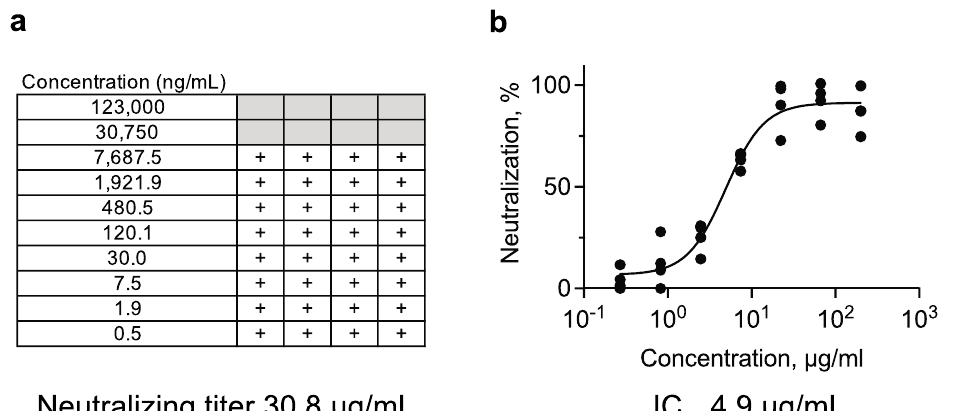
Figure 3. Comparison of methods to determine the neutralizing titer of an OC43 neutralizing monoclonal antibody. Serial